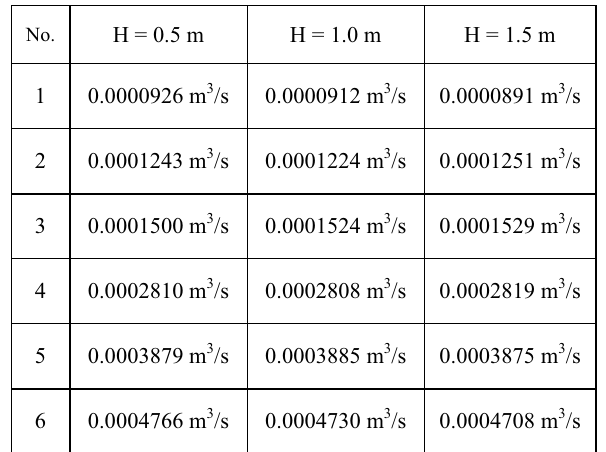
Table 1. Water flow rate for each measurement points and the distance between the drops generator and the splash fill.